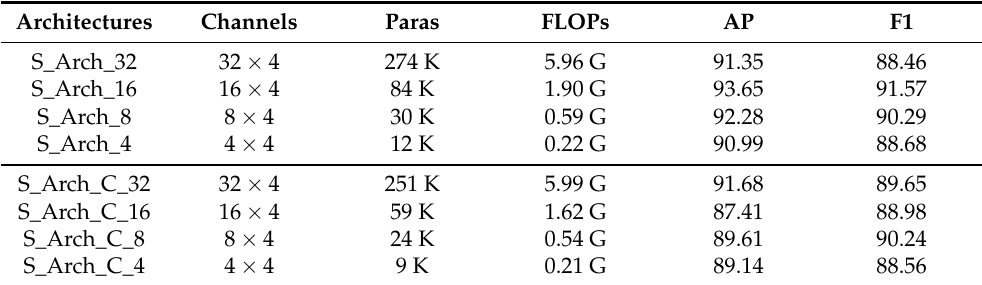
Table 6. Detection results over SSDD (the first four are obtained by setting ops _ ratio = 0, and the last four are obtained by setting ops _ ratio = 0.003).